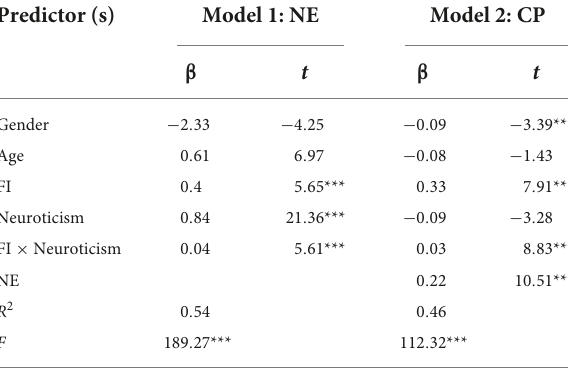
Table 1 . The results indicated that the relationship between all variables were statistically significant, and family incivility was